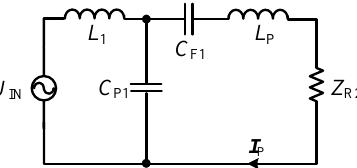
Figure 7. Equivalent M -type model of the LCC-S compensation topology for the CV-output.